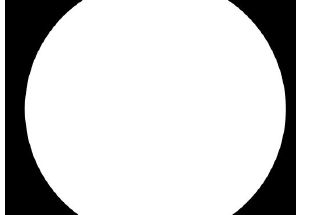
Figure 1. The effective area of the imager with the Samyang 8mm lens.